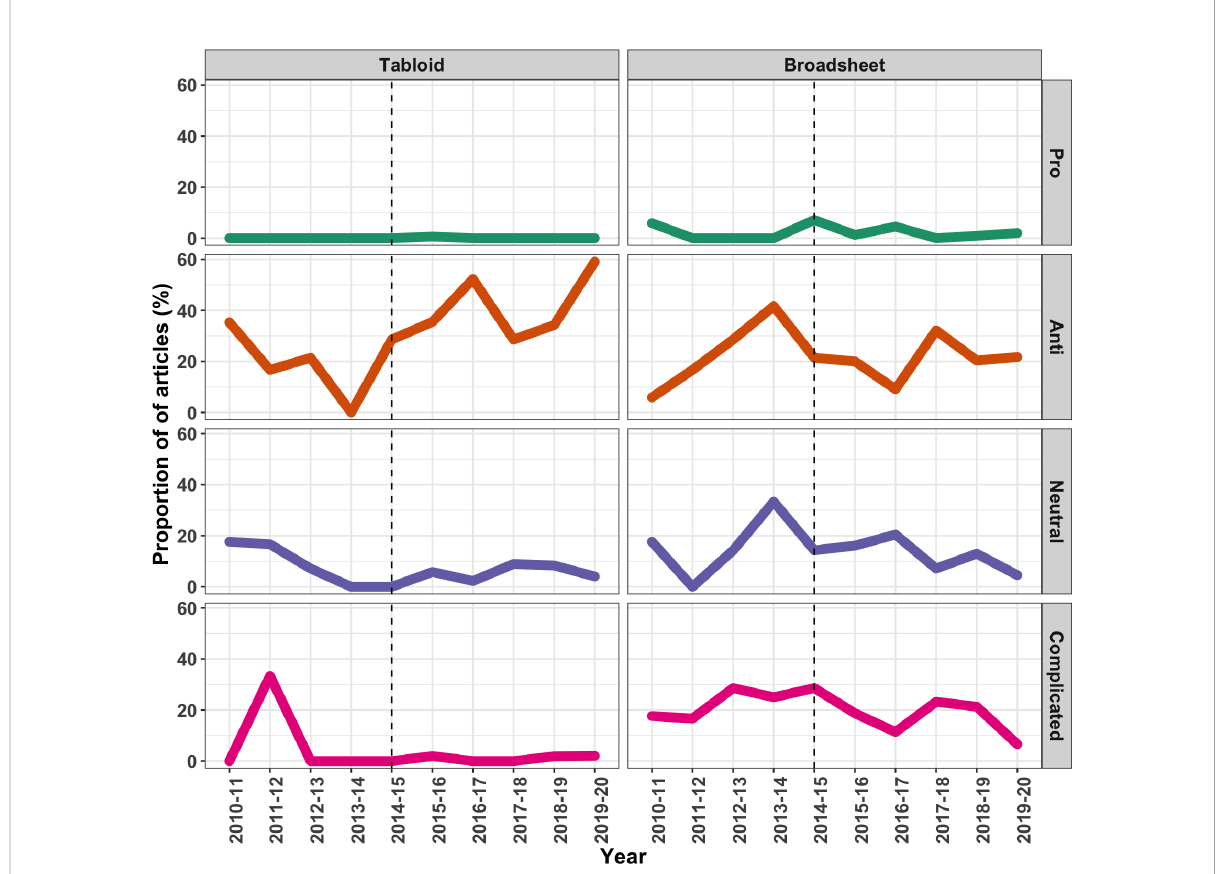
FIGURE 4 Proportion of tabloid (left) and broadsheet (right) articles by sentiment each year between 1 July 2010 and 30 June 2020. Colors indicate sentiment type. Dotted line indicates July 2015, when Cecil the lion was